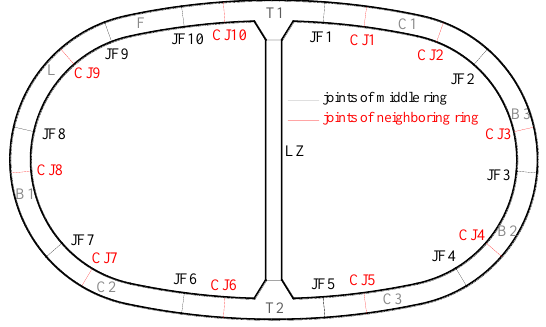
Figure 16. Layout of joints in middle and neighboring rings.